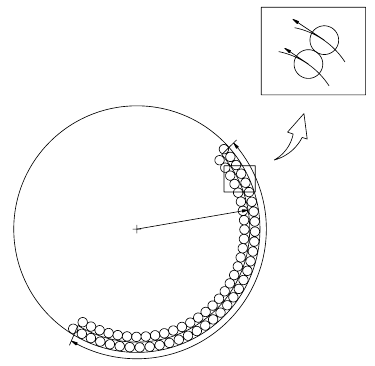
Fig. 7 Surface Formed Between Contiguous Shells with Differ- ent Rotational